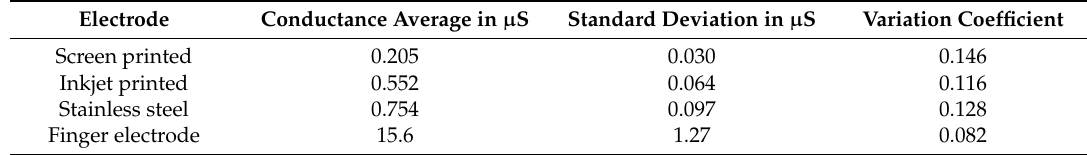
Table 1. Mean value, standard deviation and variation coefficient of the EDA